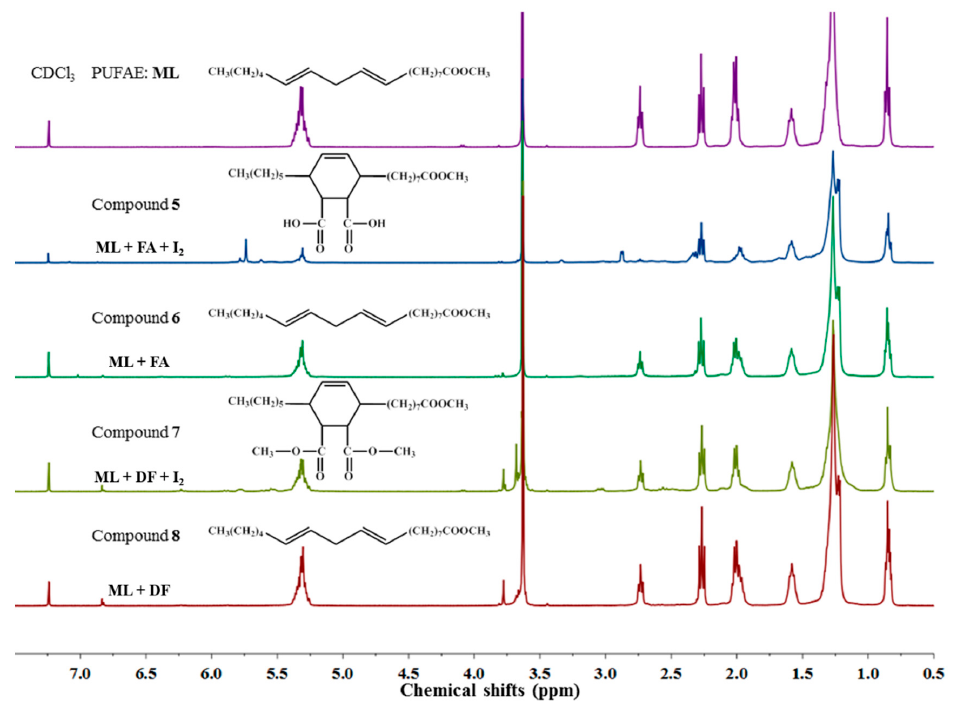
Figure 2. 1 H-NMR spectra of methyl linoleate (ML) and the reaction compounds with dienophiles in chloroform-d under di ff erent catalyst conditions: compound 5 , reaction products of ML and FA with iodine catalysis; compound 6 , reaction products of ML and FA without iodine catalysis; compound 7 , reaction products of ML and DF with iodine catalysis; compound 8 , reaction products of ML and DF without iodine